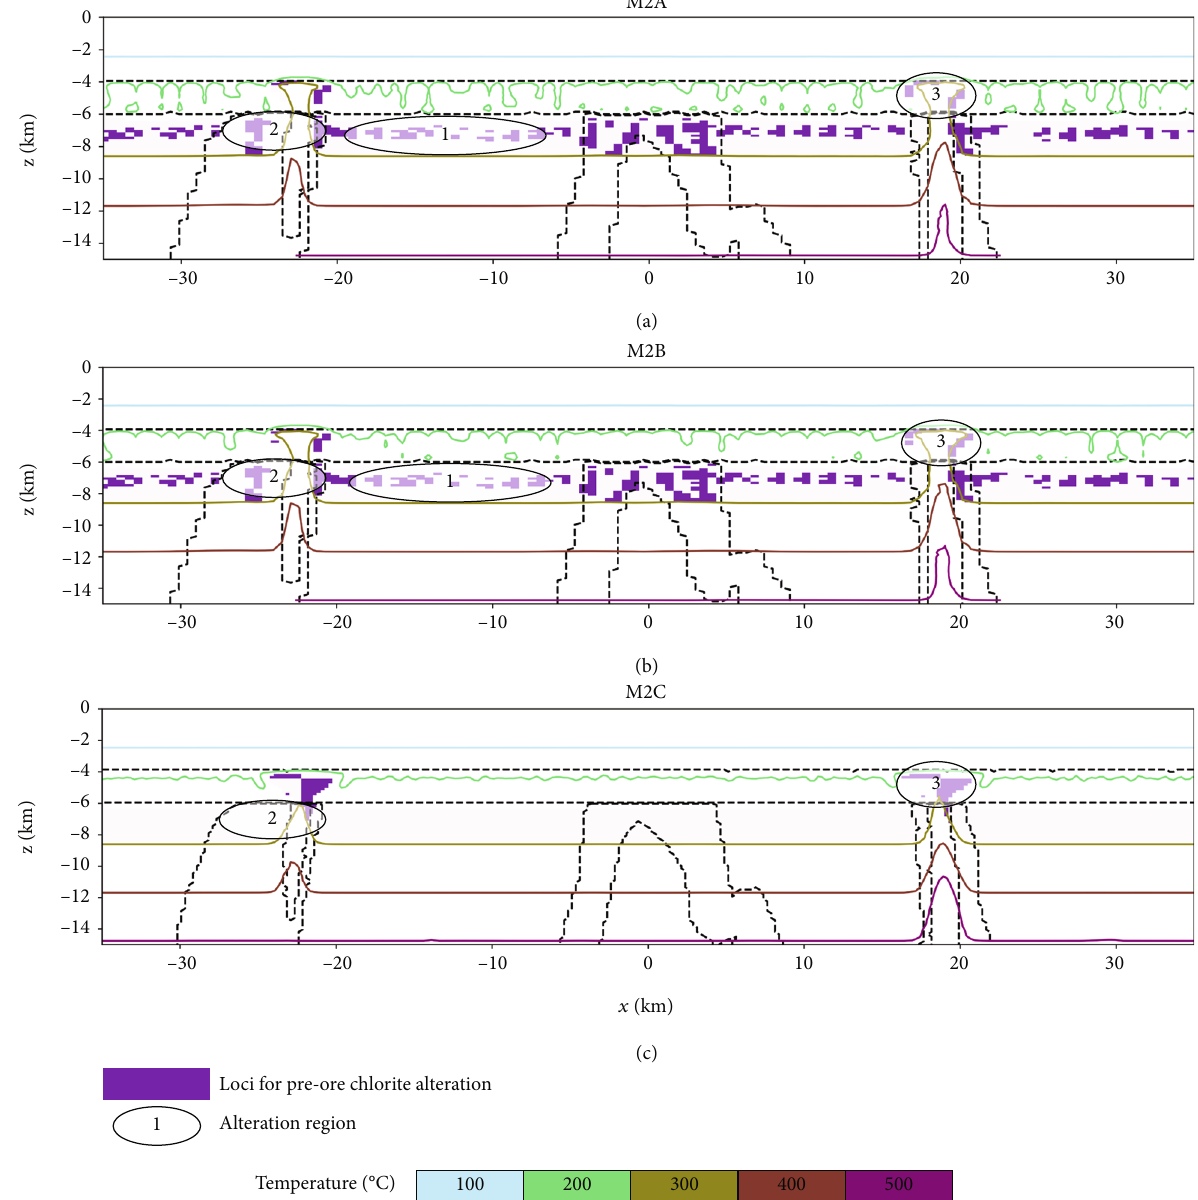
Figure 8: RRAI application to delineate loci for potential preore chlorite alteration seen with (a) M2A with the simpli fi ed dual-pressure regime, (b) M2B with the simpli fi ed dual-pressure regime and an open bottom boundary, and (c) M2C with the hydrostatic pressure regime. Partially shaded ellipses labelled 1, 2, and 3 in M2A correspond to the spatial distribution of the alteration regions and are described in detail in the text. Colour fi ll for the isotherms is based on scienti fi c colour maps